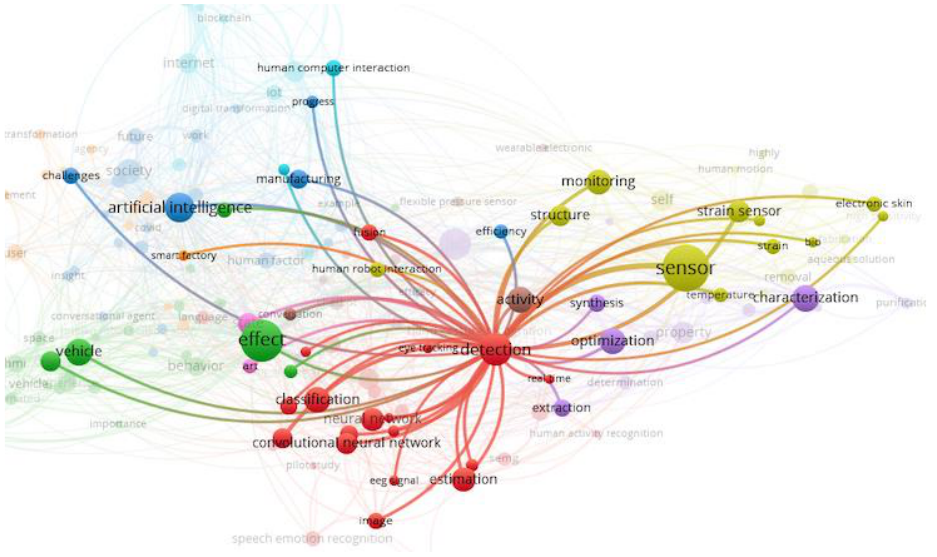
Figure 21. Detection dependency.